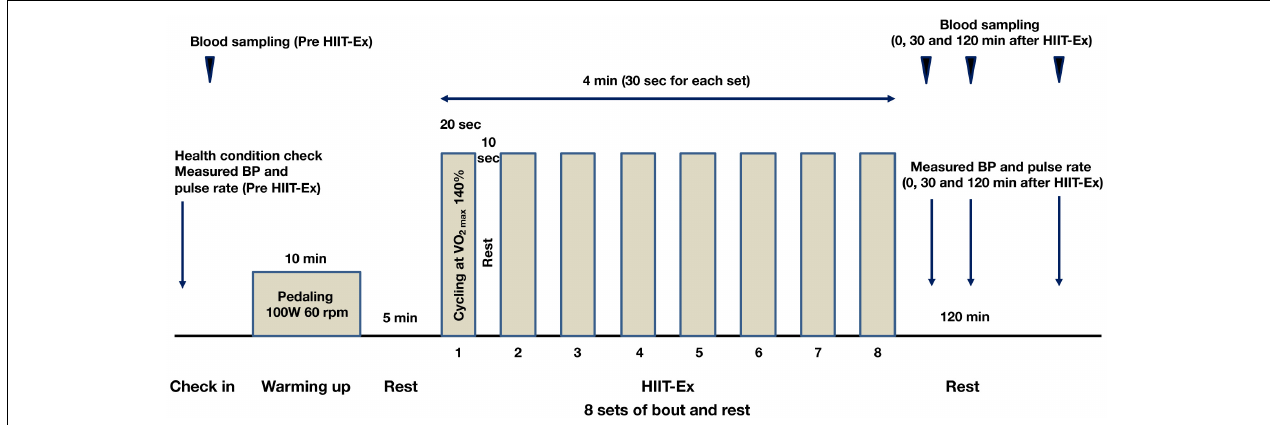
FIGURE 1 | Protocol of high-intensity interval training exercise (HIIT-Ex). Eight sets, comprising exercise bout (cycling at 140% of VO 2 max for 20 s) and rest for 10 s, were performed during a single session of HIIT-Ex. W, watt; rpm, revolutions per minute.